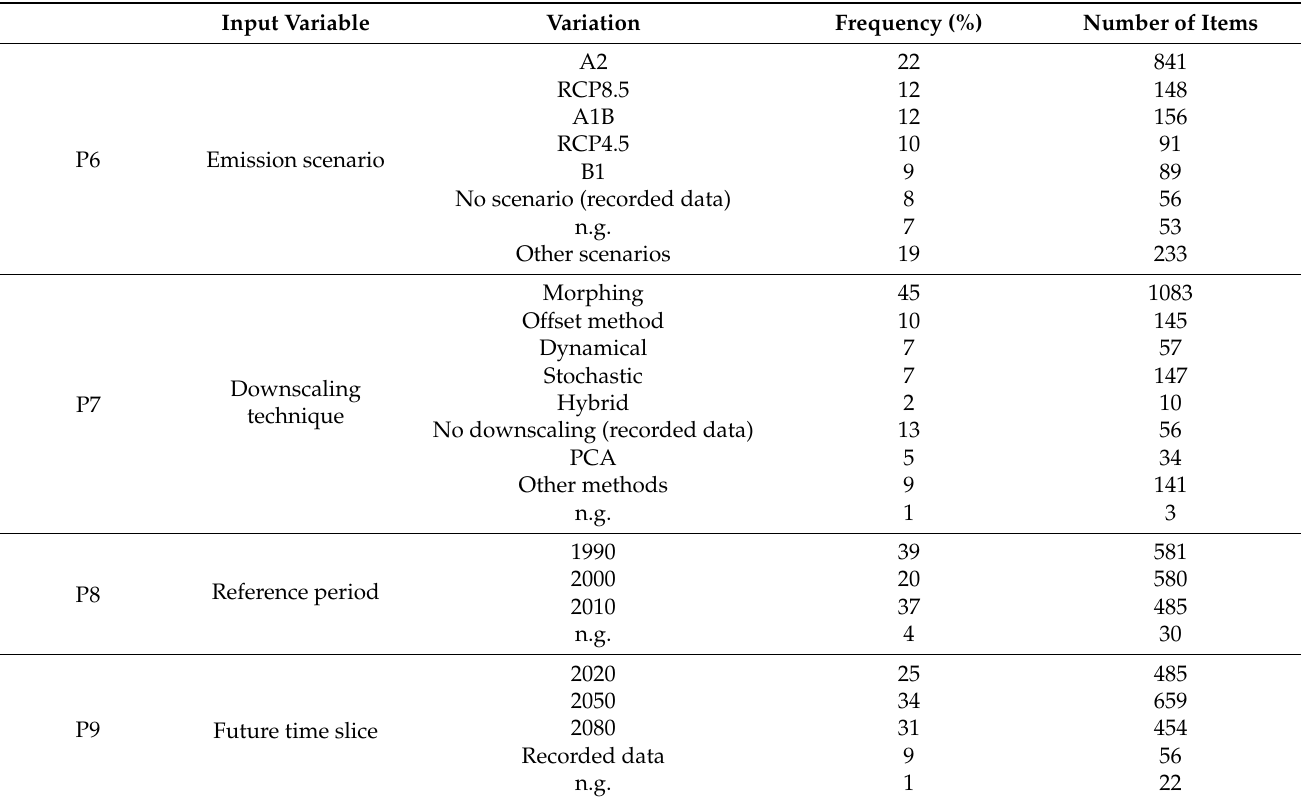
Table 4. List of extracted parameters related to the methodological framework. The abbreviation n.g. stands for